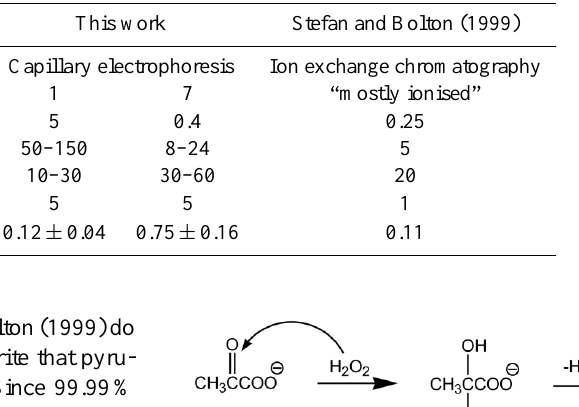
Table 3. Comparison of this work’s reaction conditions with Stefan and Bolton’s (1999).